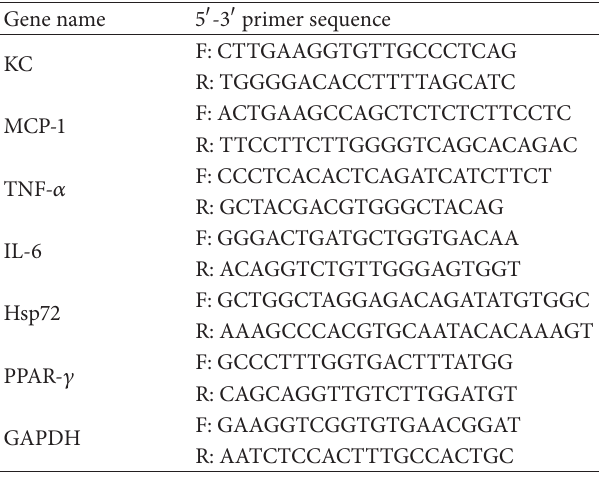
Table 1: Primer sequences used in the quantitative real-time reverse-transcription polymerase chain reaction